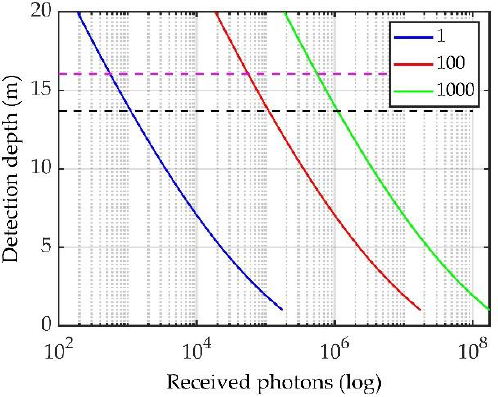
Figure 12. Variation in the number of Brillouin scattering photons with the measurement